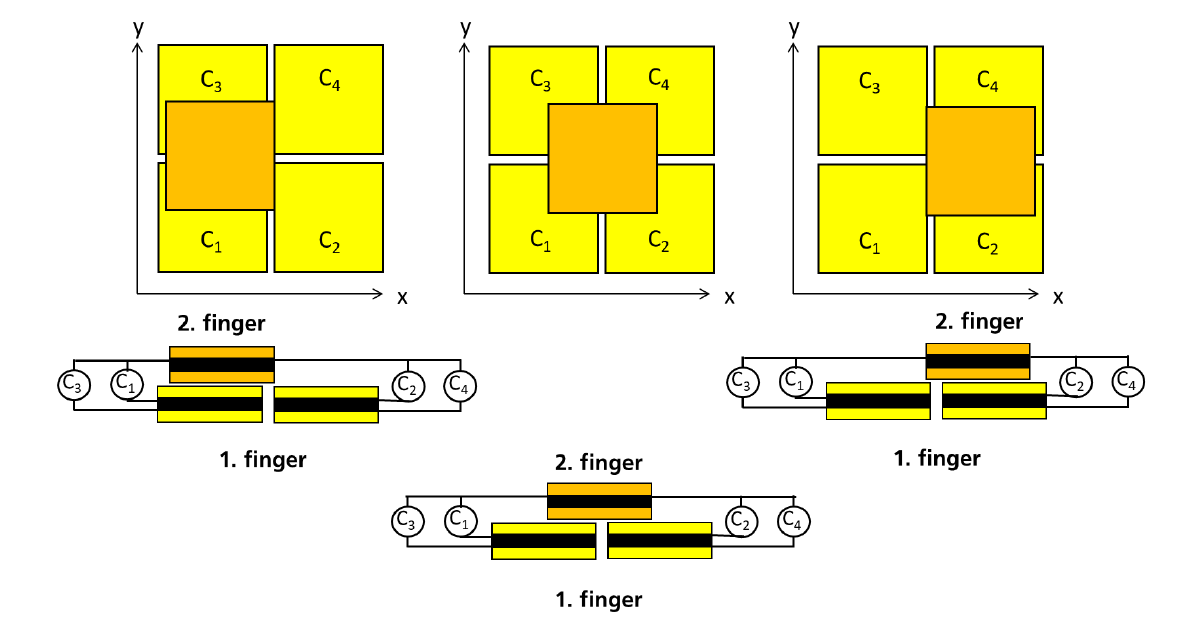
Figure 28. Schematic representation of the working mechanism of a 2D sliding or shear sensor with four electrodes with dielectric layers on one finger and one electrode with dielectric layers on another finger of a hand in top view ( top ) and side view ( bottom ), where the electrodes with dielectric layers, which contribute to the capacitances C 3 and C 4 are not visible in the side view [106].